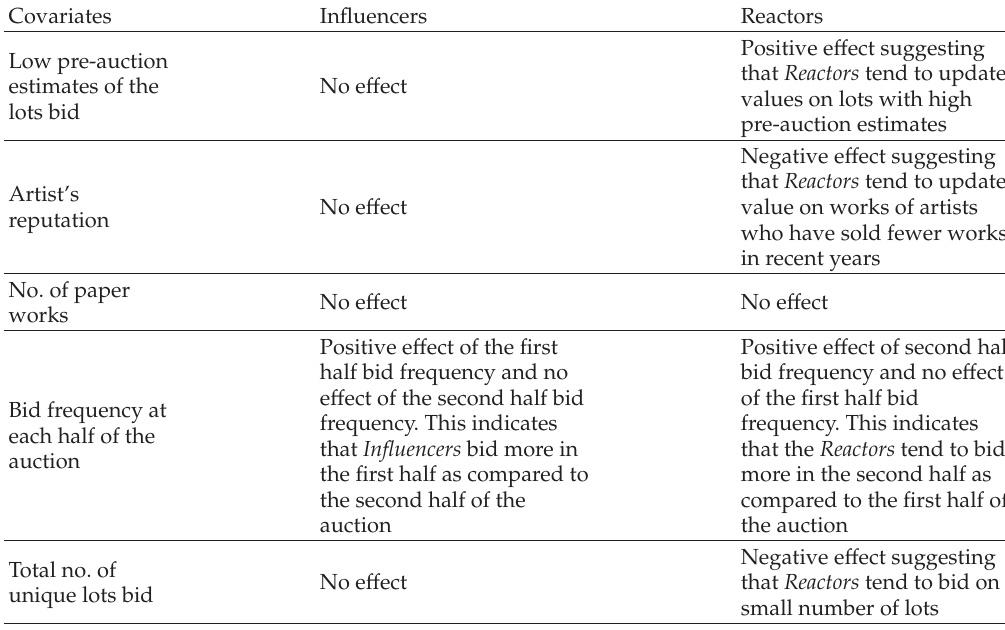
Table 5: Summary of the findings.